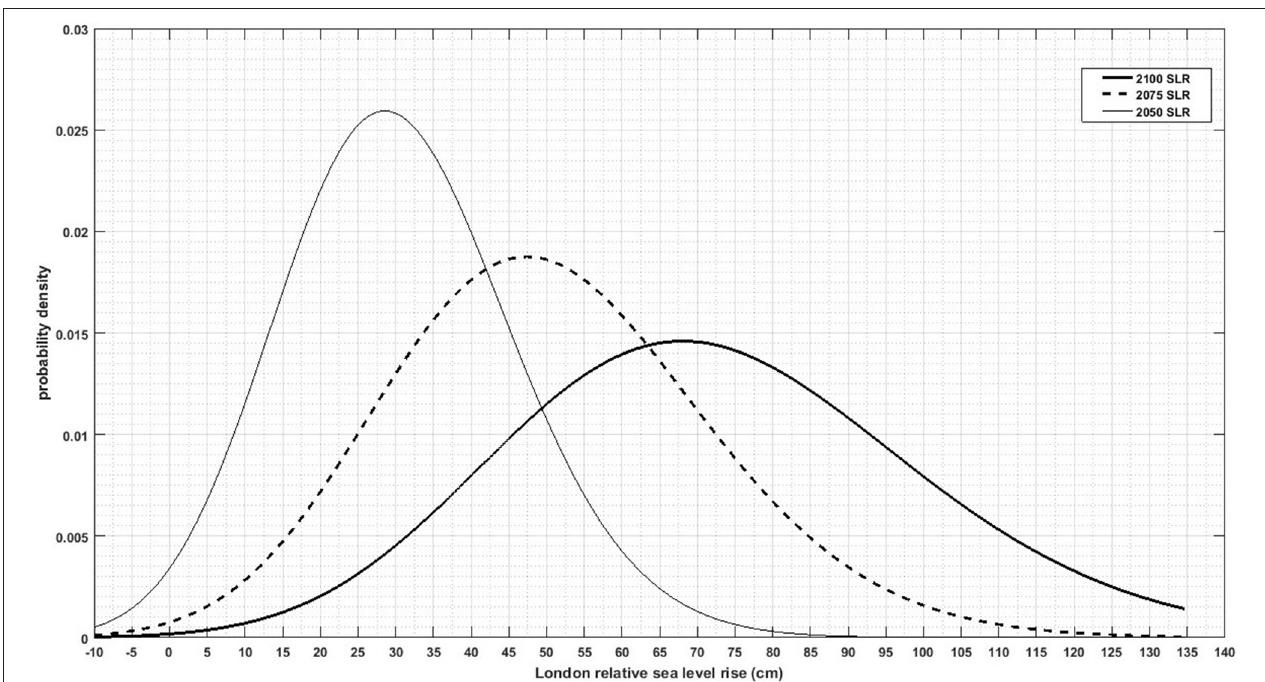
FIGURE 1 | Probability distribution for scenario RCP 8.5 over time for